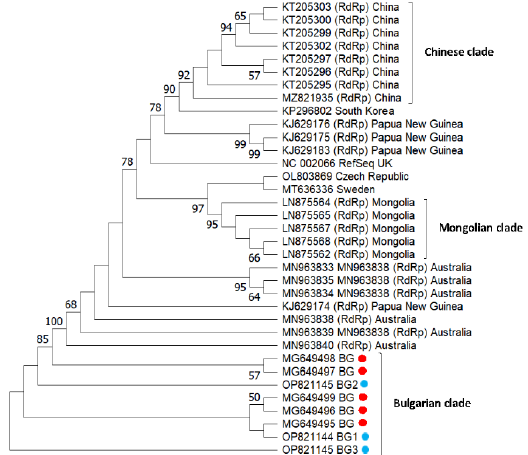
Figure 4. Phylogeny of sacbrood virus (SBV) isolates from Bulgaria and other countries. The un- rooted phylogenetic tree was constructed based on the alignment of the part of nonstructural